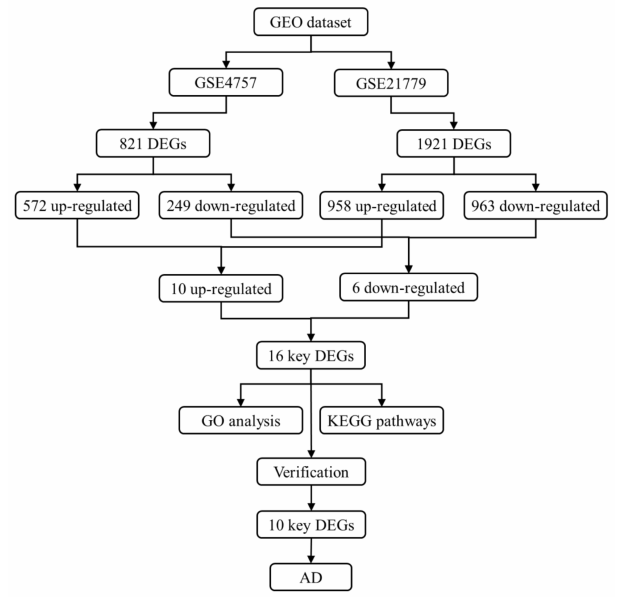
Figure 1. The analysis flow chart of this study. DEGs: differentially expressed genes; GO: gene ontology; KEGG: Kyoto Encyclopedia of Genes and Genomes; AD: Alzheimer’s disease.